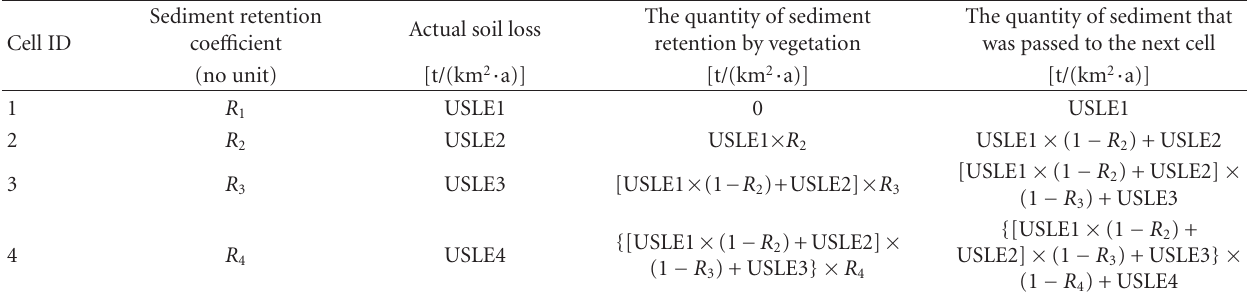
Table 1: The model of calculating the quantity of sediment retention by vegetation in each cell followed by the flow path. Cell